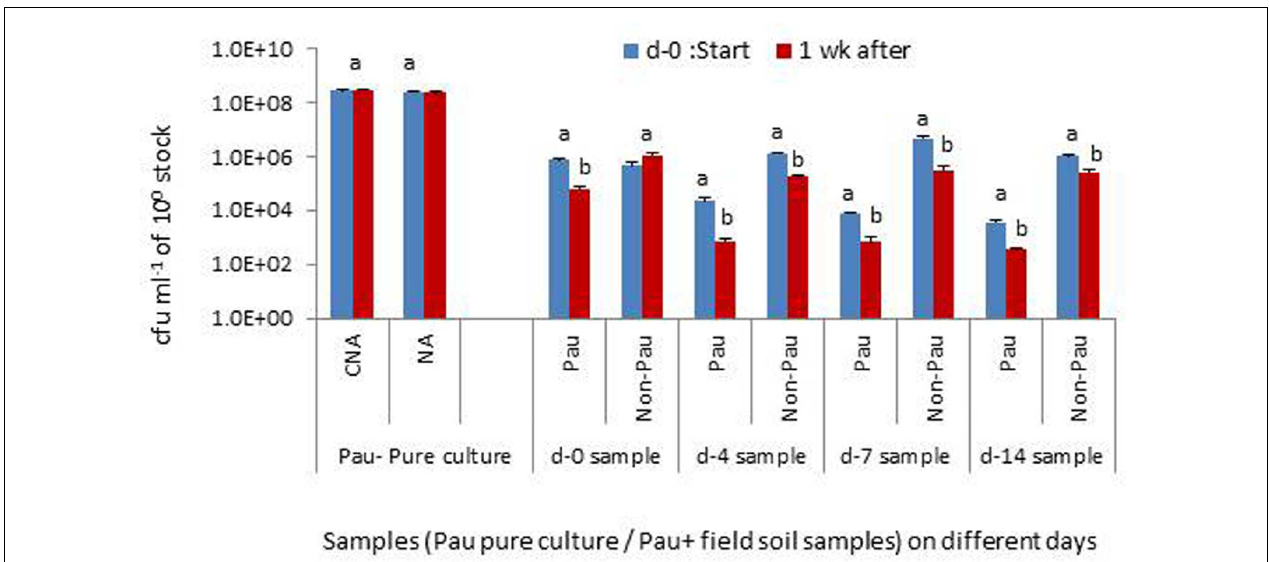
FIGURE 9 | Testing the interactive effect of P. aeruginosa ( Pau ) with soil microbiota in suspension employing the soil suspensions prepared on days 0, 4, 7 or 14, with static incubation for 1 week after the preparation, in comparison with the pure culture employing CNA for Pau and NA for non- Pau estimations (10 0 stock refers to 0.1 OD anchored stock for the pure culture and 1 g per 10 ml for the soil suspension; Bars with different letters in a treatment set are significantly different at P =